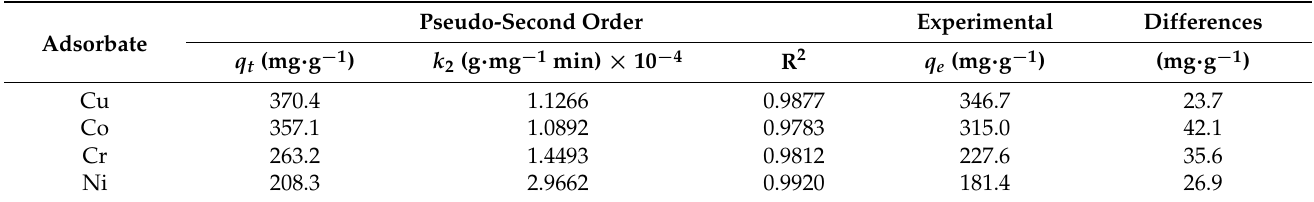
Figure 11. Pseudo-second-order kinetic plots of adsorption by polymer ligand; experimental condi- tions: 100 mg of poly(hydroxamic acid), 10 mL of 0.1 M CH 3 COONa buffer solution, and 5 mL of 0.1 M heavy metal at pH 6 agitated for 2 h. Table 2. Pseudo-second-order rate of adsorption of metal ions by poly(hydroxamic acid) ligand.